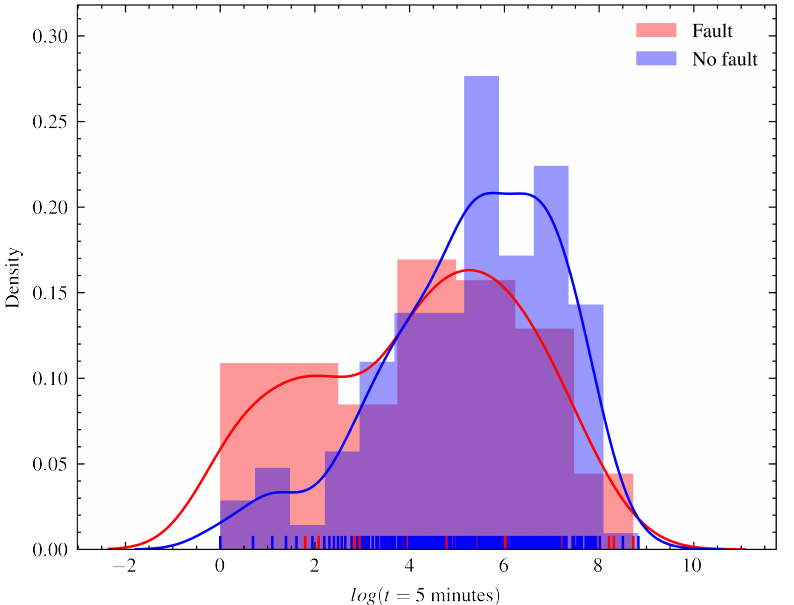
Figure 1. Distribution chart of the last operating cycle time registered for runs with and without faults. The time cycle scale was converted to the logarithmic scale in order to better show the distribution of the variable. The average maximum cycle time of failed runs is less than that of normal operations. The distribution of both presents a bimodal characteristic, with two different concentration points more clearly verified in the faulty